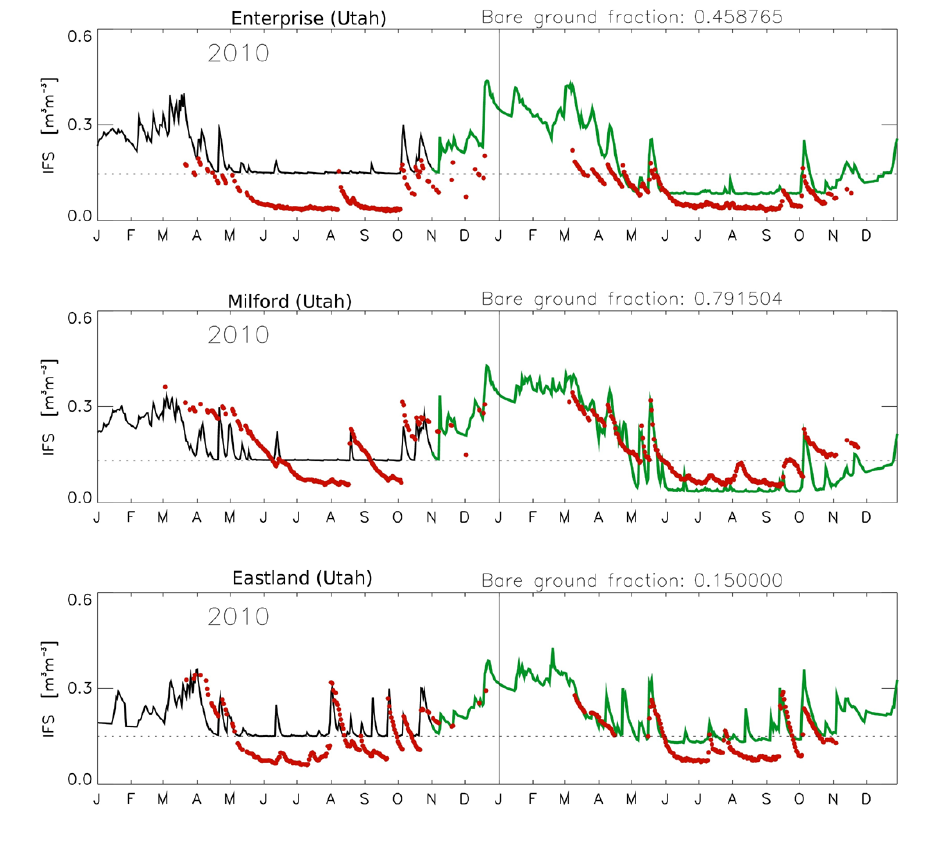
Fig. 5. Time-series of the operational volumetric soil moisture analysis for three sites in Utah for the 2010–2011 period. The black solid line becomes green when the new bare ground evaporation formulation is implemented in November 2010. Red dots are for in situ observations of surface soil moisture. Fraction of bare ground (according to the model) for each site is indicated. The dashed line represents the model minimum soil moisture limit before the implementation of the new bare ground evaporation (permanent wilting